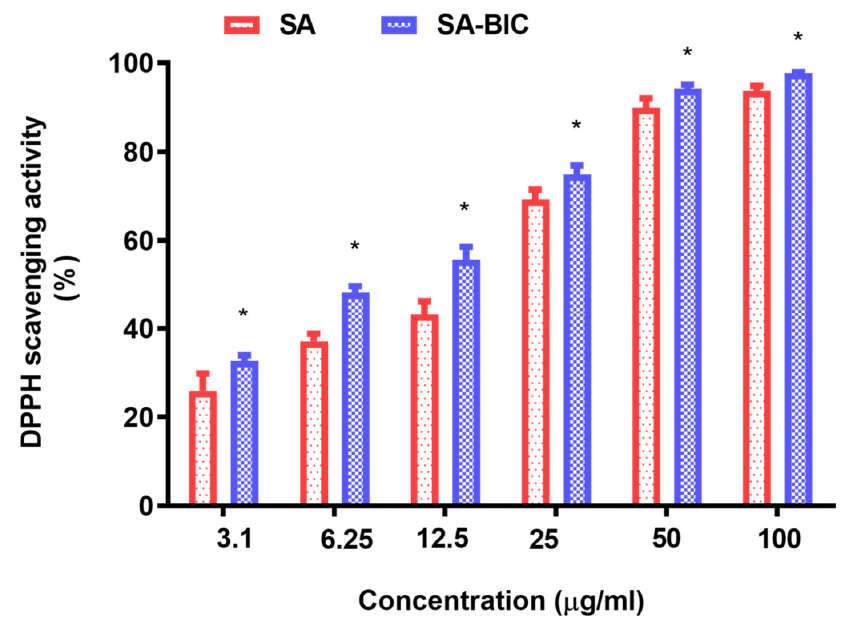
Figure 8. Antioxidant activity profile of pure SA and BIC. * p < 0.05 as compared to